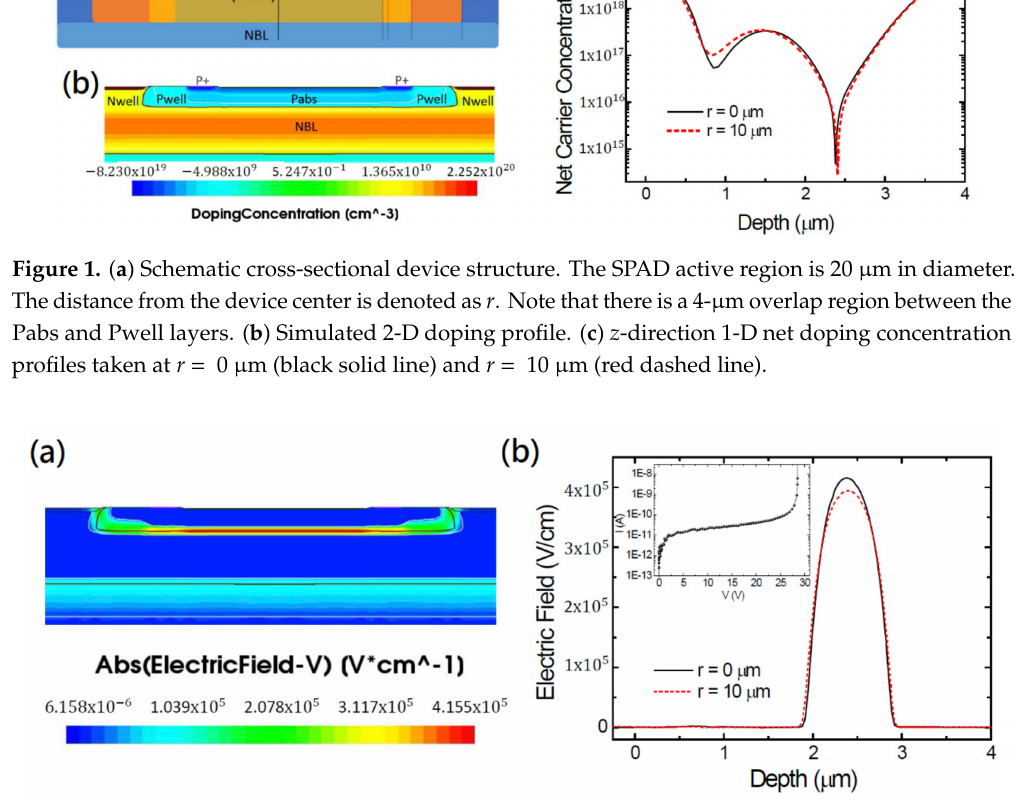
Figure 2. ( a ) Simulated 2-D electric-field strength distribution of the single-photon avalanche diodes (SPAD) biased at 28.0 V; ( b ) Cross-sectional electric-field strength profiles at device center ( r = 0 µ m, solid black line) and at the edge ( r = 10 µ m, red dashed line), respectively, as a function of the depth. Inset on Figure 2b: simulated I-V